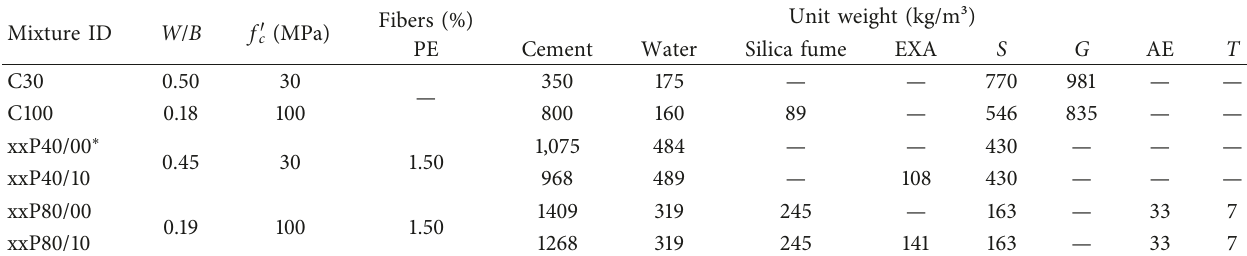
Table 1: Design of the conventional concrete and SHCC mixtures.